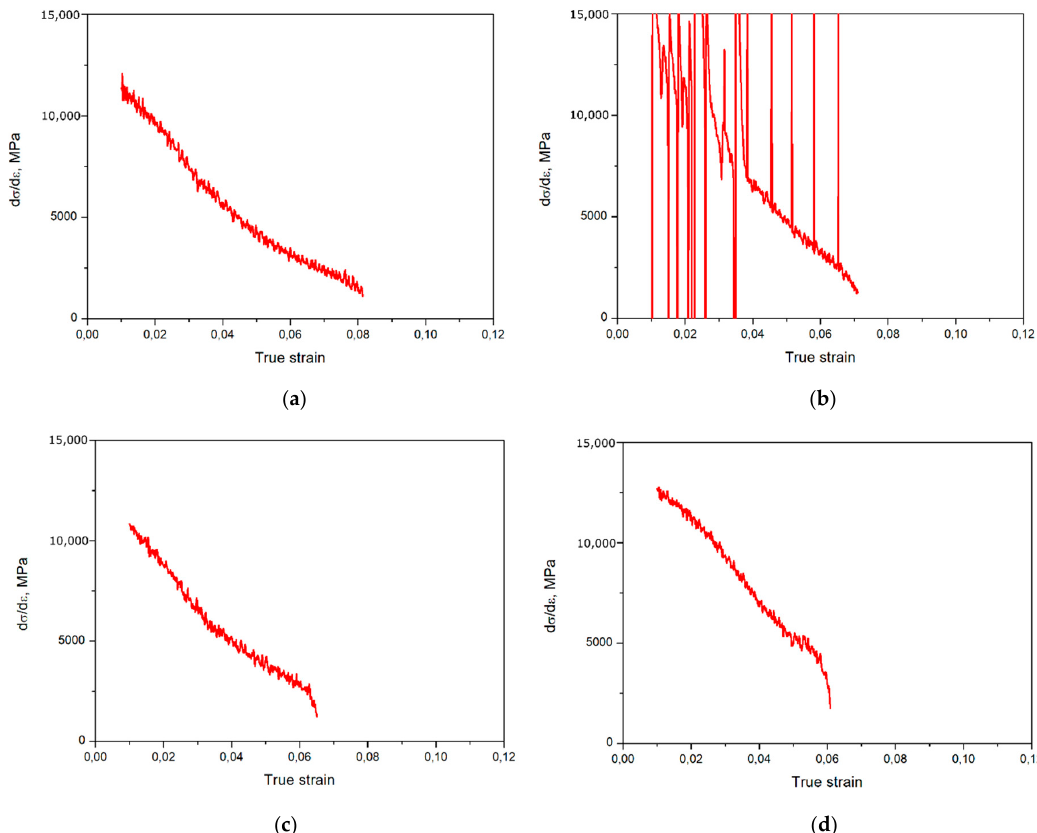
Figure 3. Work hardening rate as a function of true strain (uniform deformation range) at: (a) 20 ° C, (b) 60 ° C, (c) 100 ° C, and (d) 140 ° C .